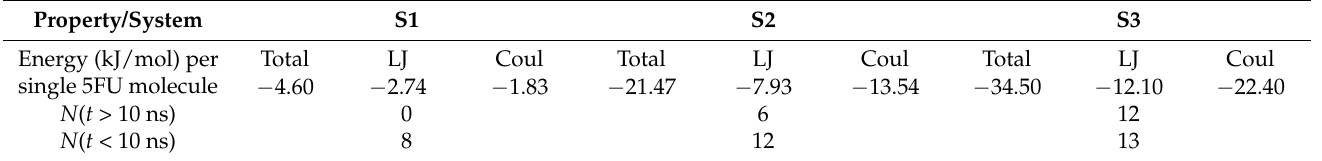
Table 5. Average pair interaction energies between 5FU molecules (LJ—Lennard-Jones contributions, Coul—electrostatic contributions) and the dendrimer and the number of 5FU molecules remaining in the dendrimer structure for more (less) than 10